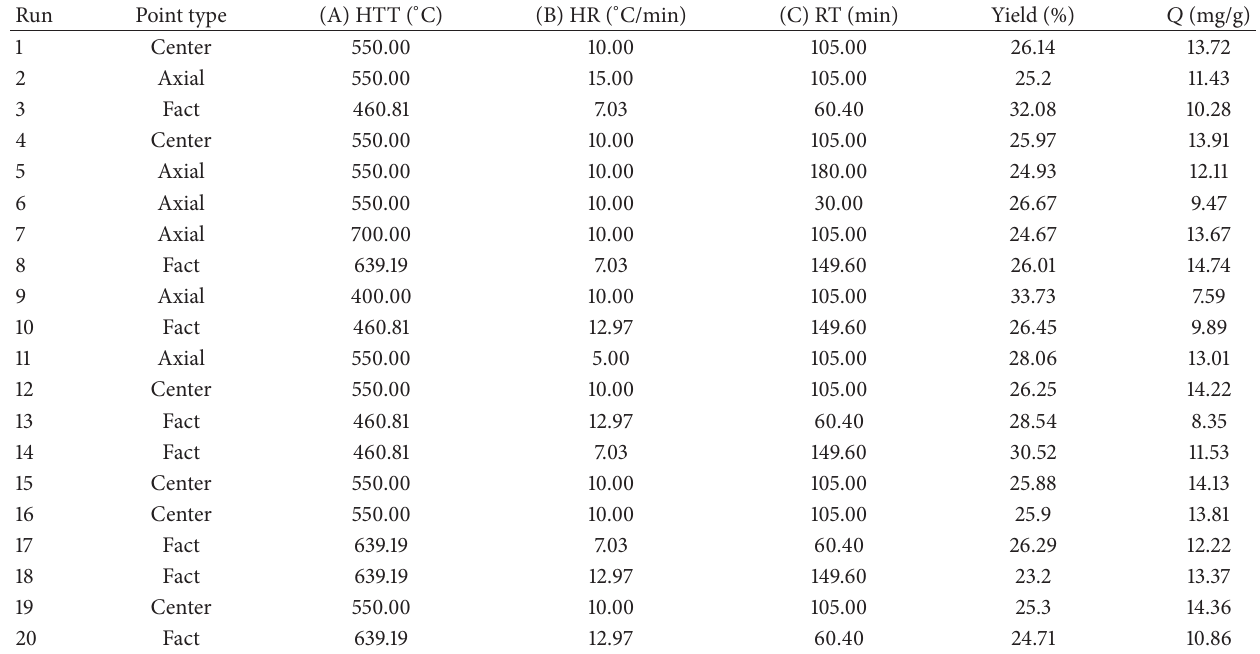
Table 2: Design matrix with results.